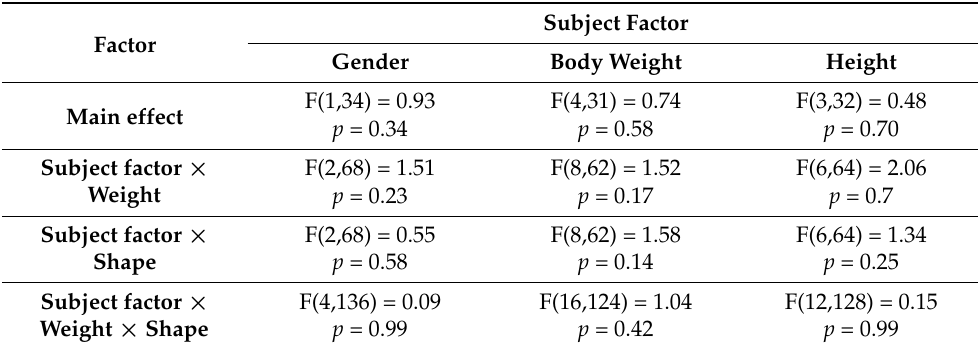
Table 4. Statistical significance of individual trait